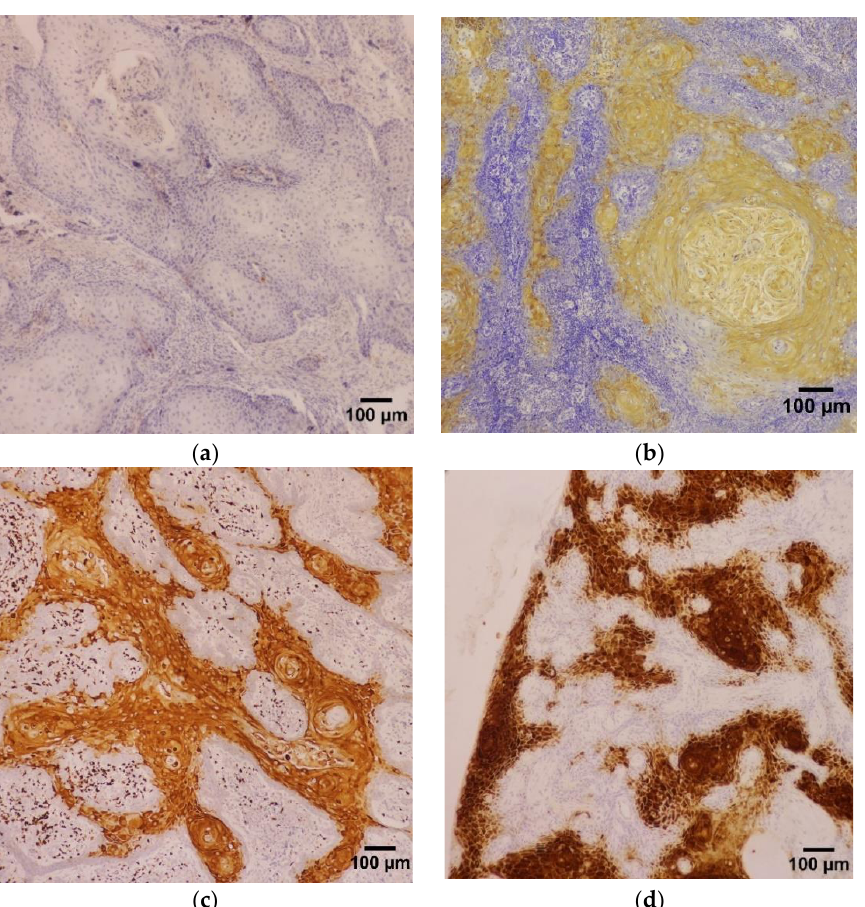
Figure 2. Photomicrographs of immunohistochemical staining of HIF-1- α in OSCC samples and the various staining intensities (magnification x100): ( a ) staining intensity 0 (none), ( b ) staining intensity 1 (weak), ( c ) staining intensity 2 (moderate), ( d ) staining intensity 3 (strong).